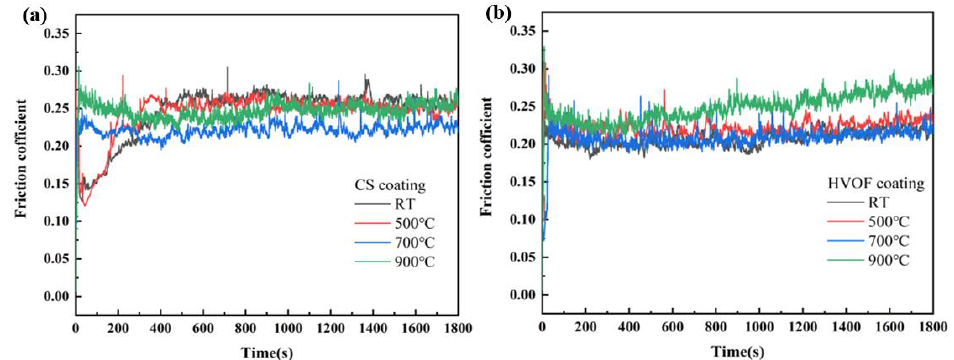
Figure 12. Friction coefficient curves of CoCrFeNiMn high-entropy alloy coatings. ( a ) CS coatings; ( b ) HVOF coatings.